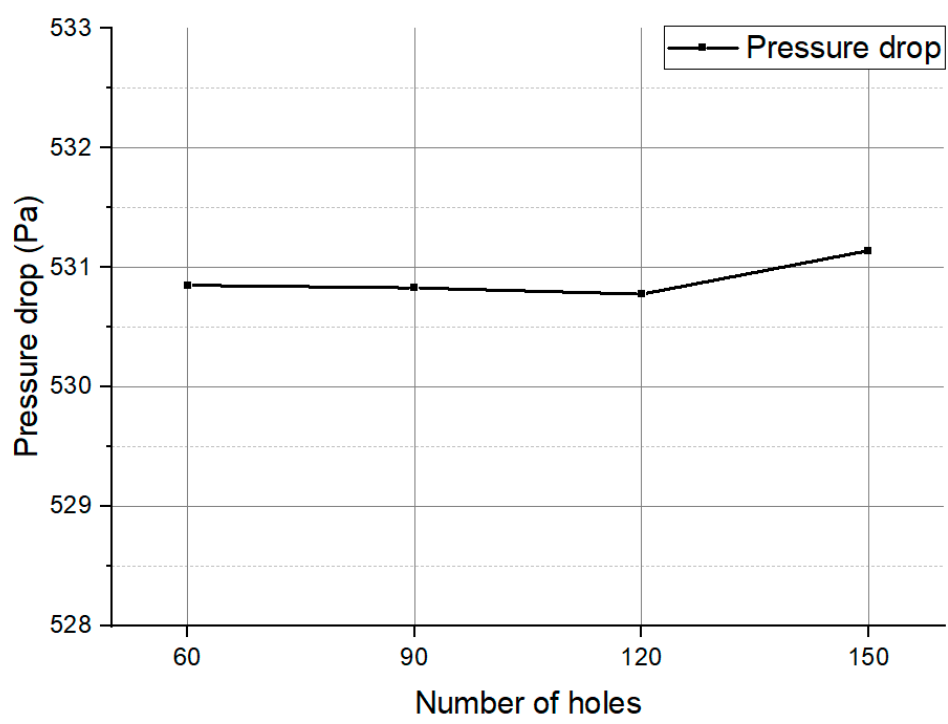
Figure 30. Pressure contour according to the number of holes in the outer resonate type.